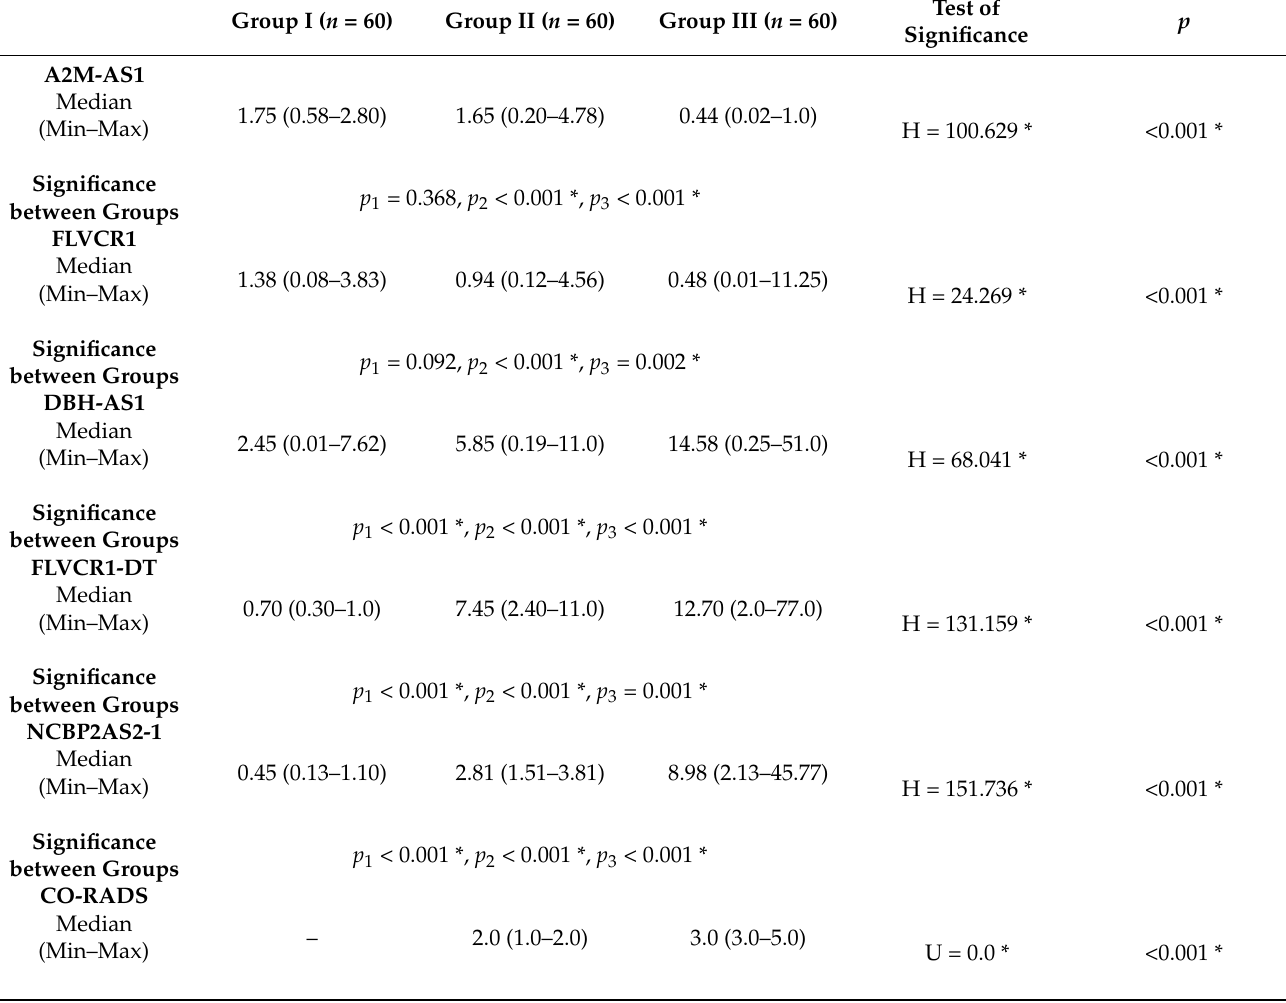
Table 2. Comparison between the three studied groups according to different parameters.